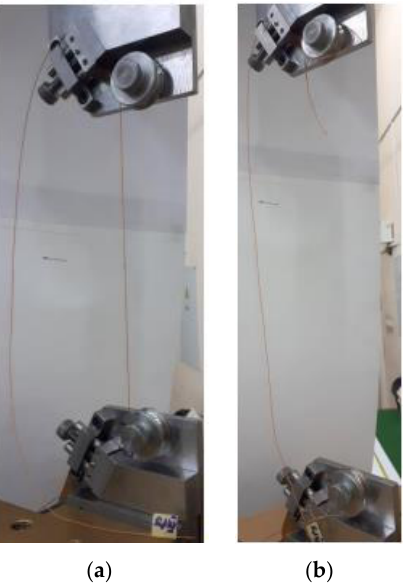
Figure 7. Photos of tested sample of cord III: ( a ) before test and ( b ) after test.